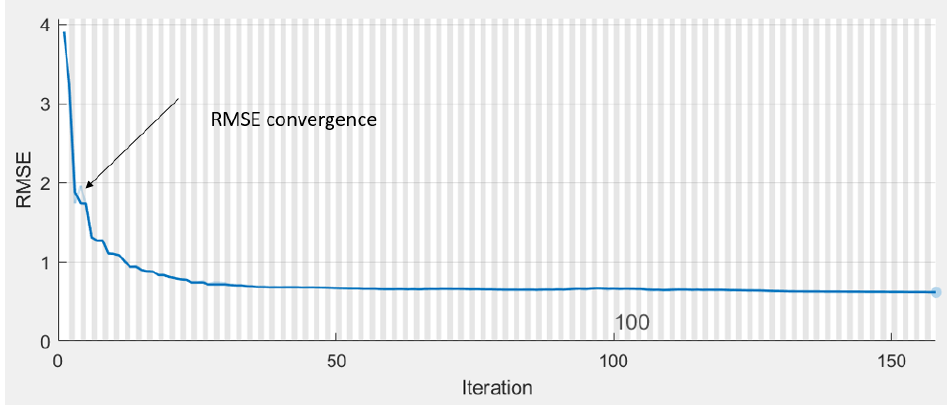
Figure 8. Convergence of the LSTM training.